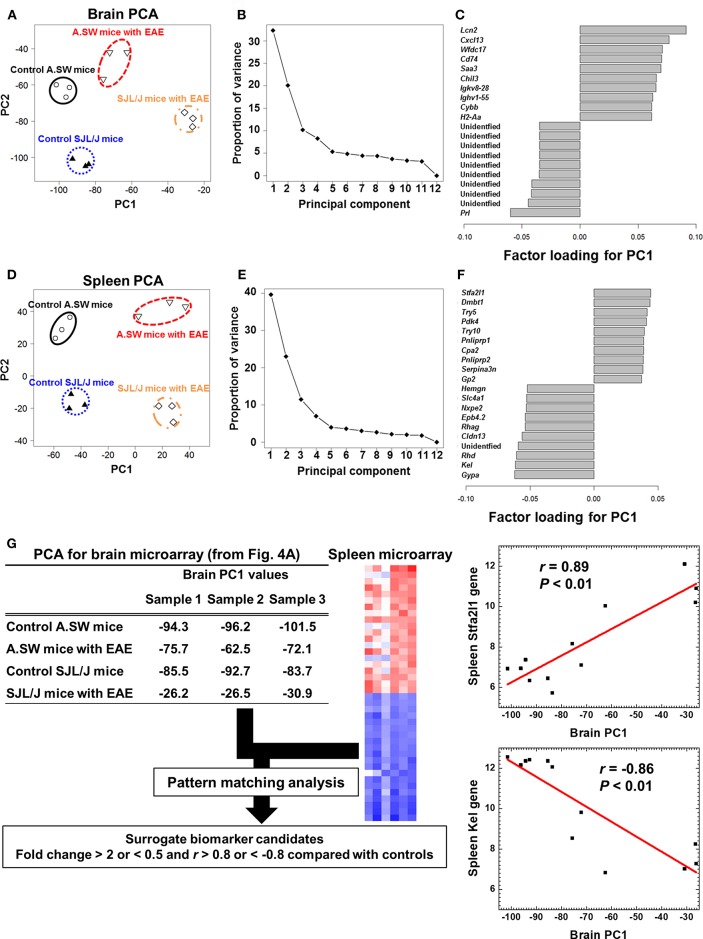
(A–F) Principal component analysis (PCA) of transcriptome data of brains and spleens from A.SW and SJL/J mice with PP-EAE and control mice. PCA separated the samples into four groups in both brains (A) and spleens (D), where principal component (PC) 1 reflected the presence of EAE, while PC2 reflected strain difference. The proportion of variance showed that PC1 explained variance among samples 33% in the brains (B) and 40% in the spleens (E). In the brain (C), factor loading for PC1 showed that up-regulation of immune response-related genes, including lipocalin 2 (Lcn2), CXCL13, and immunoglobulins, and down-regulation of prolactin (Prl) contributed to PC1 values. In the factor loading for PC1 of spleen PCA (F), stefin A2 like 1 (Stfa2l1) and erythrocyte-related genes (Gypa, Kel, and Rhd) contributed to PC1 distribution positively and negatively, respectively. Transcriptome data from three PP-EAE and three naïve mice of each strain were used. (G) A flow chart of pattern matching analysis using brain PC1 values and spleen microarray data from A.SW and SJL/J mice. To find peripheral surrogate biomarkers that reflect the changes in the brain, we conducted pattern matching analysis. Genes whose fold changes were >2 or <0.5 with correlation coefficients of >0.8 or <-0.8 were identified as surrogate marker candidates (Supplemental Table 15). Stfa2l1 and Kel genes, which were up- and down-regulated significantly in the spleens of PP-EAE mice, respectively, were strongly correlated with brain PC1 values (Stfa2l1: r = 0.89, P < 0.01; Kel: r = −0.86, P < 0.01). We used microarray data of brains and spleens of three mice with PP-EAE and three age-matched control mice for each mouse strain (the total number of mice = 12).